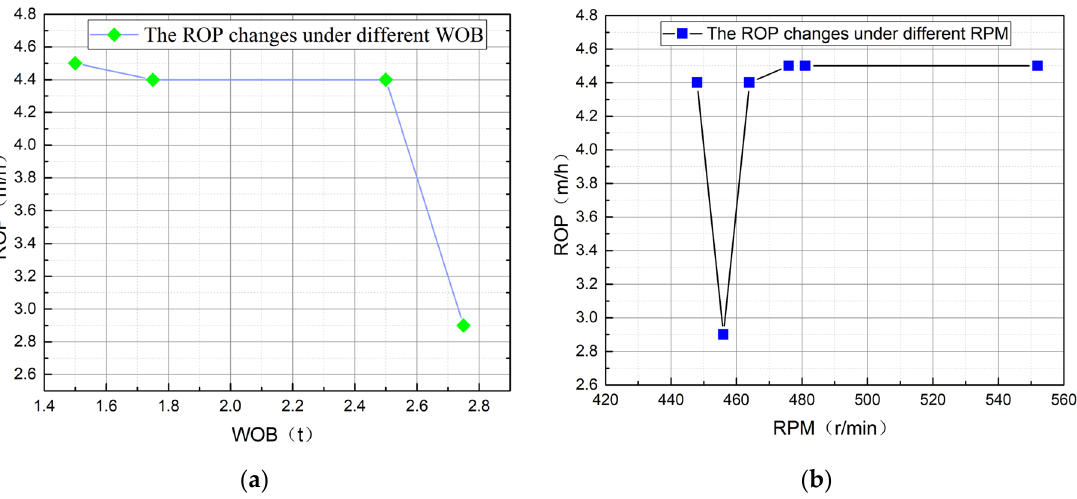
Figure 9. Data of diamond core bit: ( a ) The ROP changes under different WOB; ( b ) The ROP changes under different